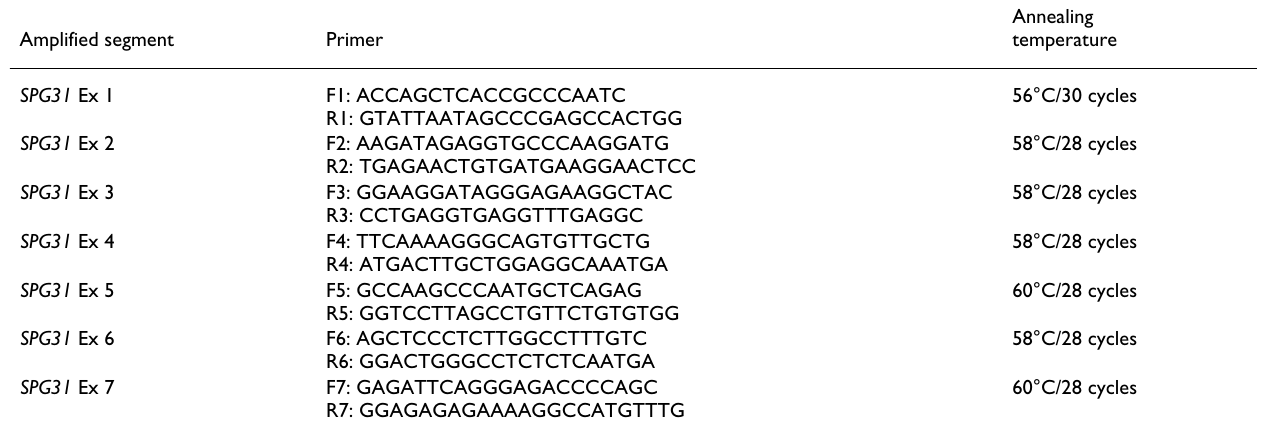
Table 1: Primer sequences and annealing temperatures Amplified